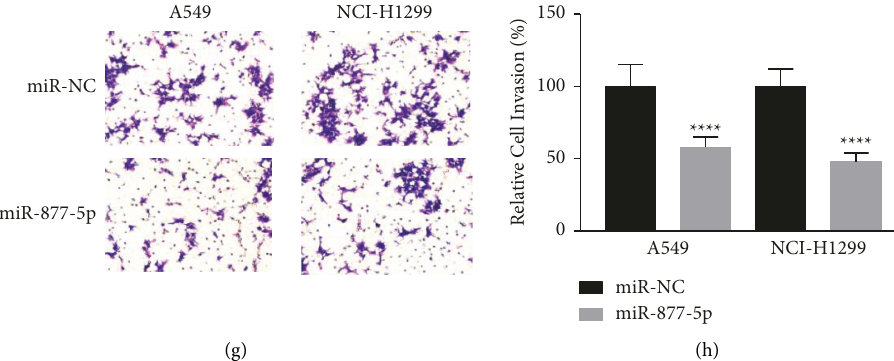
Figure 2: Overexpression of miR-877-5p regulates the proliferation, migration, and invasion of A549 and NCI-H1299 cells. miR-877-5p mimics or miR-NC were transfected into A549 (a) and NCI-H1299 (b) cells. The proliferative ability of A549 (c) and NCI-H1299 (d) cells was assayed by CCK-8. Transwell was performed to measure the migration of A549 (e) and NCI-H1299 (f) cells (magnification, x200). Transwell invasion assays of A549 (g) and NCI-H1299 (h) cells (magnification, x200). ∗ P < 0 . 05, ∗∗ P < 0 . 01, ∗∗∗ P < 0 . 001 and ∗∗∗∗ P < 0 . 0001 vs.